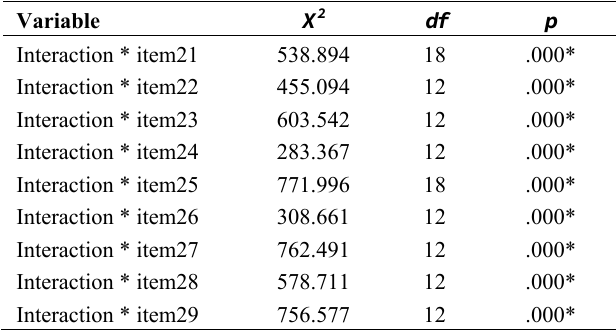
Table 9: The influence of interaction on the fuzzy